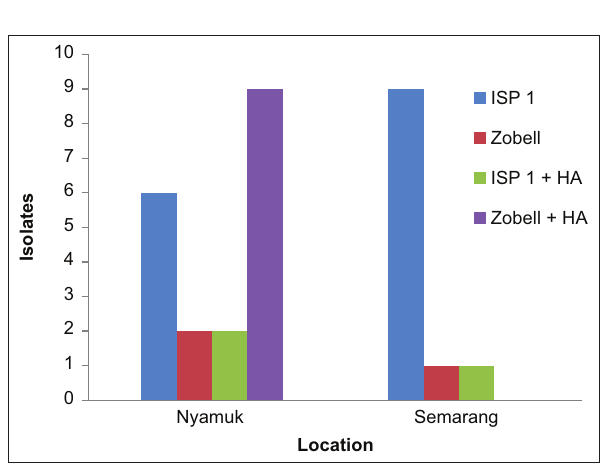
Figure-1: The number of isolates successfully obtained from Karimunjawa and Semarang based on culture media.